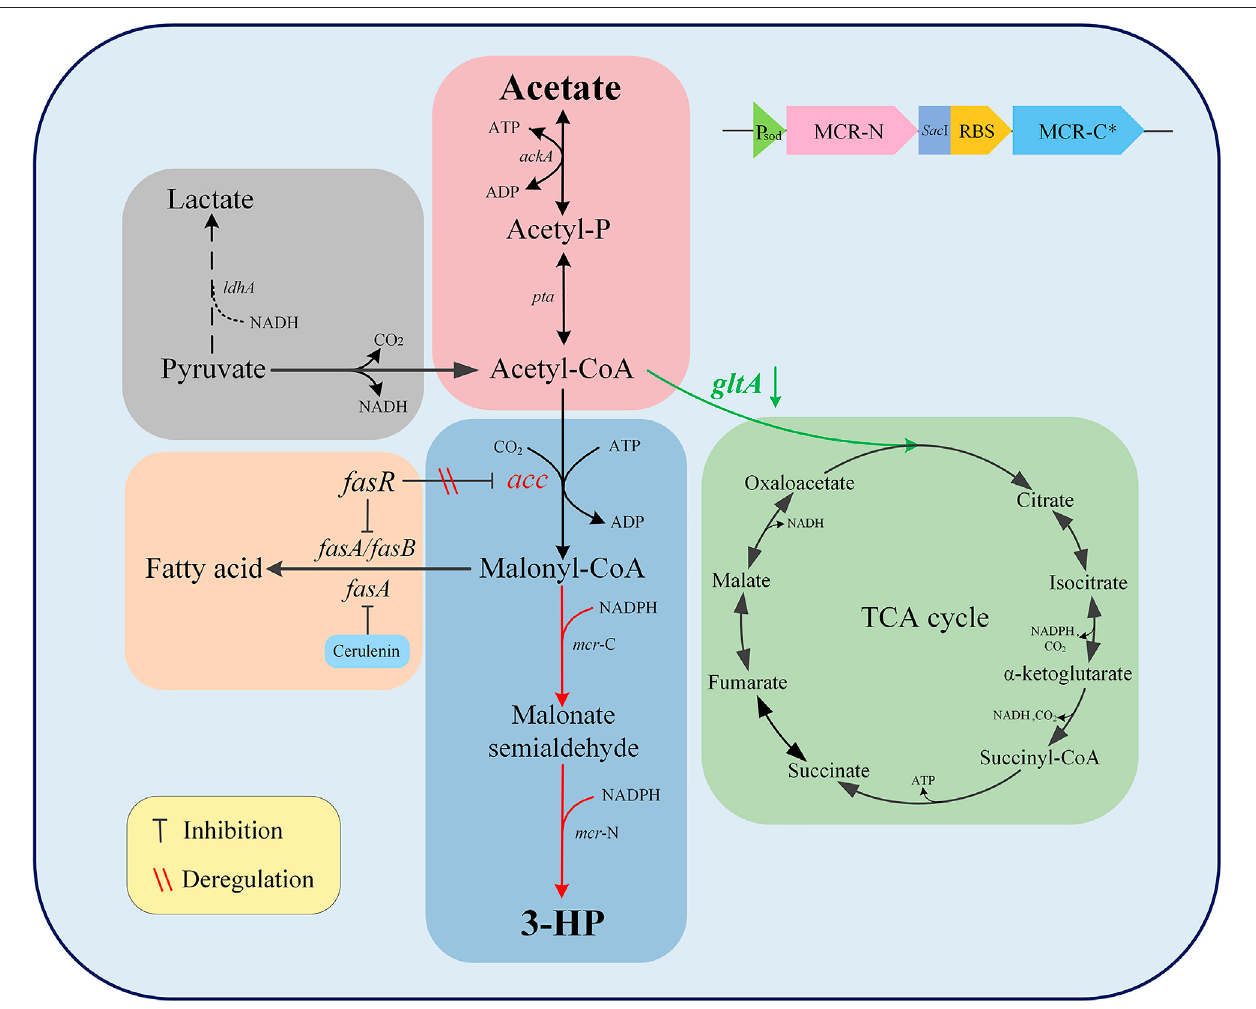
FIGURE 1 | Schematic diagram of 3-HP biosynthetic route in Corynebacterium glutamicum via acetate assimilation. Black arrows indicate the native pathways of C. glutamicum , red arrows indicate genes which were overexpressed or introduced, green arrows indicate genes which were weakened, and dotted arrows indicate genes which were deleted. Acetyl-P, acetyl phosphate; 3-HP, 3-hydroxypropionic acid; ldhA , lactate dehydrogenase; ackA , acetate kinase A; pta , acetyl phosphate transferase; acc , acetyl-CoA carboxylase; mcr- C, C-terminal of malonyl-CoA reductase; mcr- N, N-terminal of malonyl-CoA reductase; fasA , fatty acid synthetase A; fasB , fatty acid synthetase B; fasR , fatty acid repressor; gltA , citrate